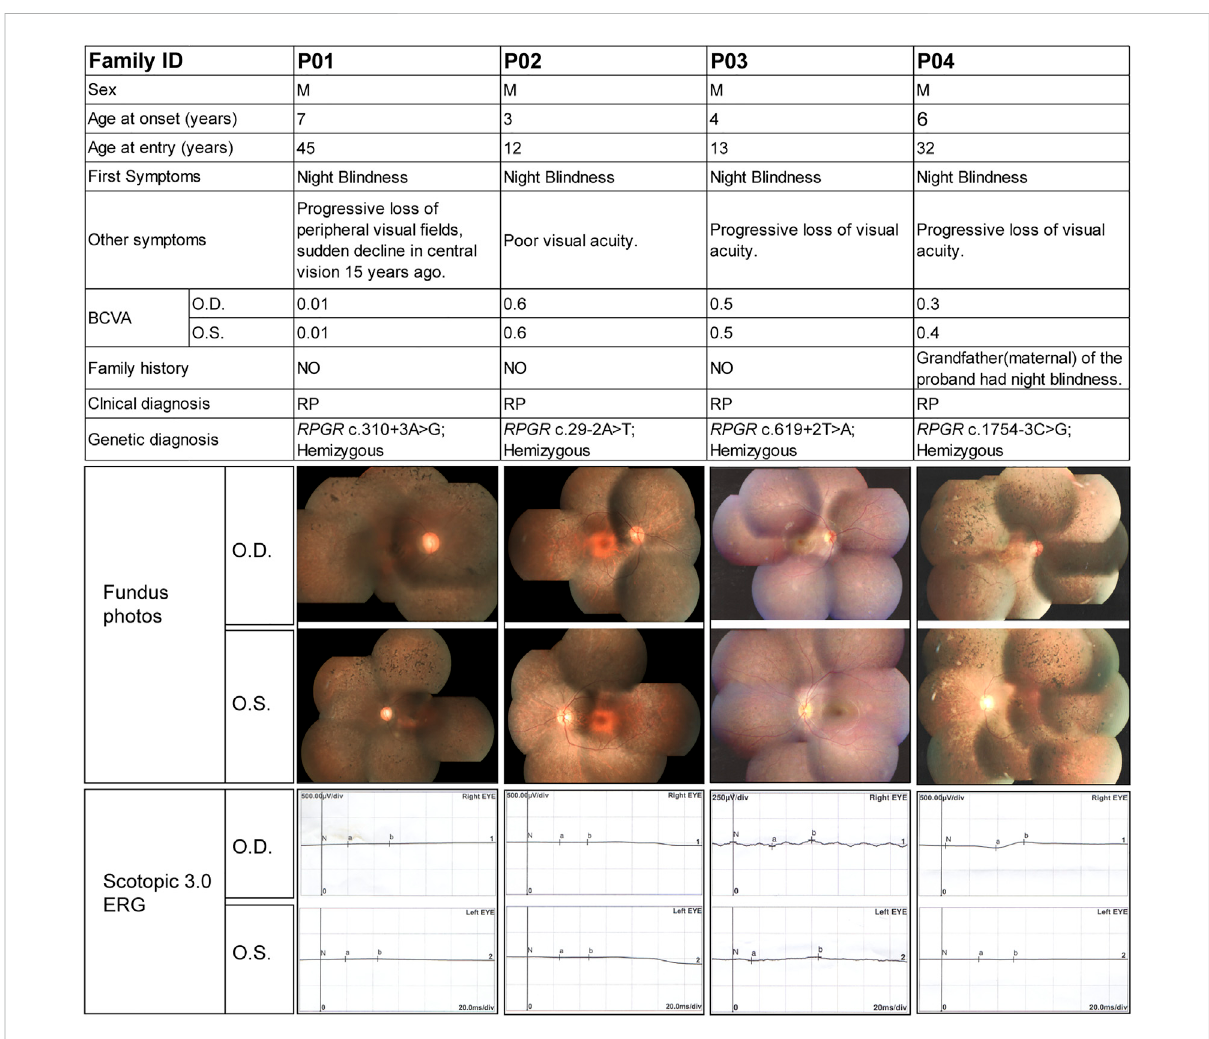
FIGURE 3 Summary of the clinical and genetic fi ndings of four patients with RP and RPGR intronic variants. The composite image shows the most important available clinical fi ndings. Each column represents a single patient with the following information in each row: family ID; sex; age of onset (as reported subjectively by the patient) and at entry; fi rst symptom ( fi rst manifestation of the disease as reported by the patient); other symptoms; best corrected visual acuity (BCVA); family history; clinical diagnosis; genotype; fundus images; and scotopic and photopic electroretinogram results. O.D., right eye; O.S., left eye; F, female; M,